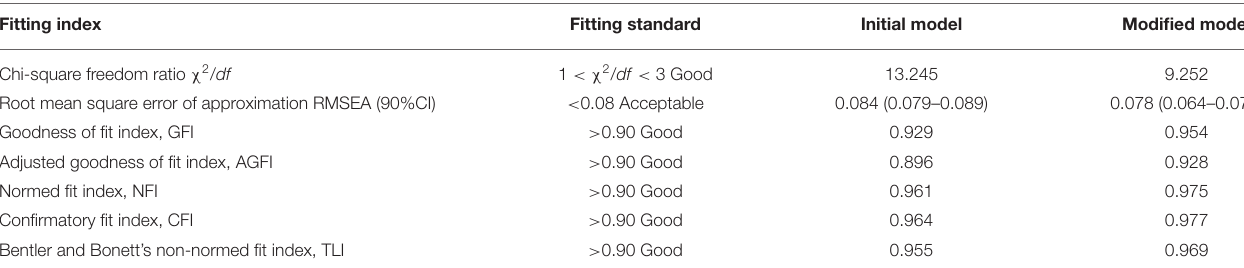
TABLE 4 | Fitting results of the structural equation model.